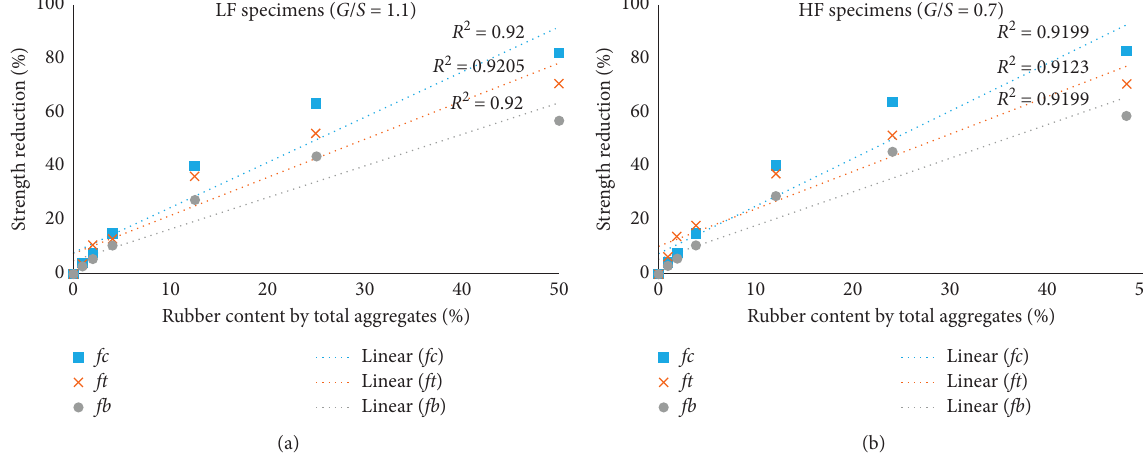
Figure 5: Effect of silicone rubber content on the compressive, tensile splitting, and bending strengths. (a) LF specimens. (b) HF specimens.